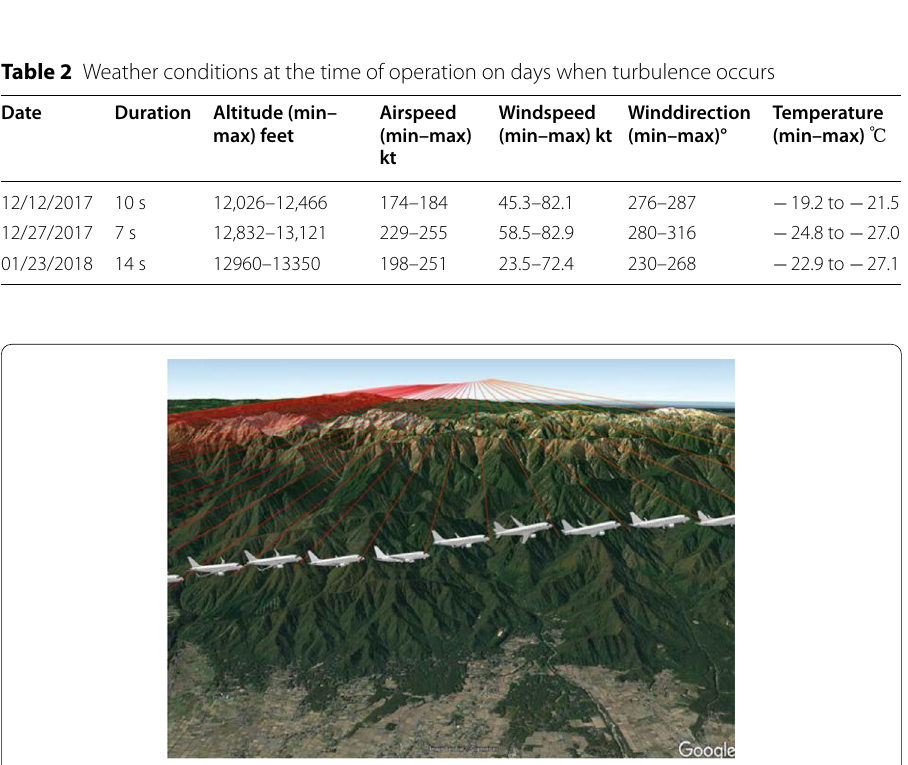
Fig. 3 Visualization of altitude changes owing to